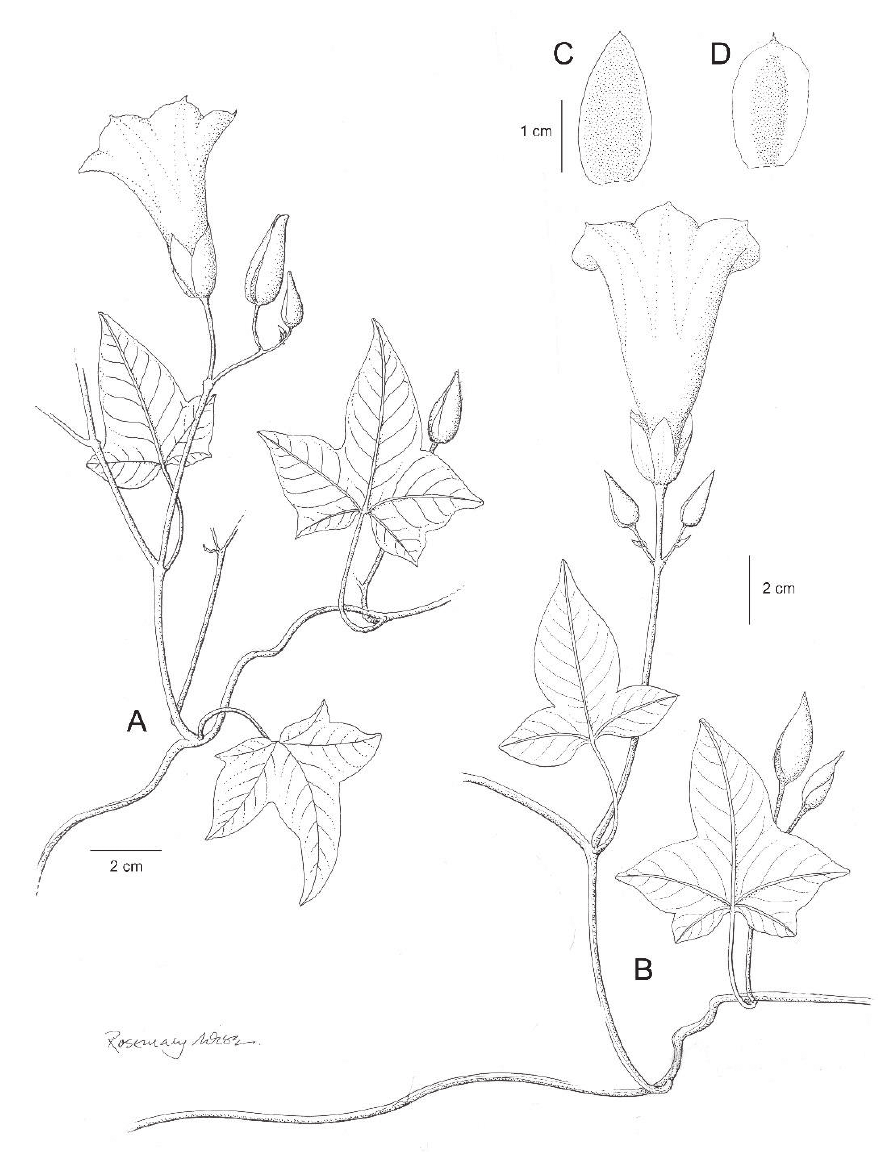
Figure 3. Ipomoea cuscoensis . A habit B habit; C outer sepal; D inner sepal. Drawn by Rosemary Wise from Galiano et al.